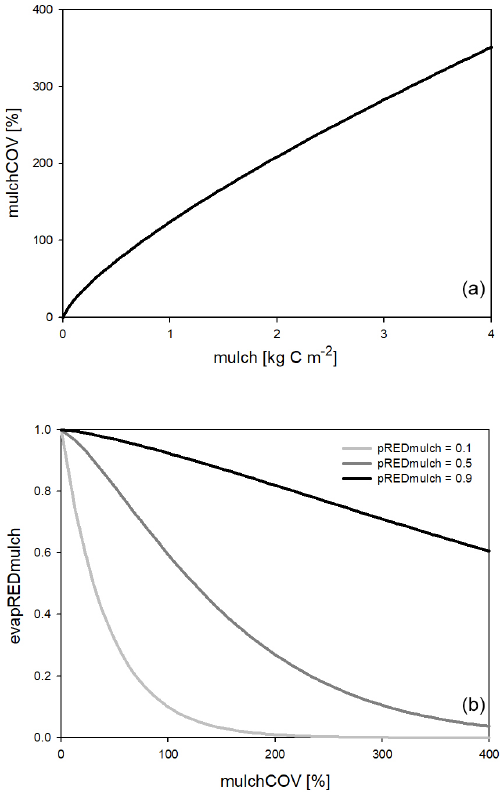
Figure 2. Surface coverage as a function of the amount of surface residue or mulch (a) and the evaporation reduction factor (evap- REDmulch) as a function of mulch coverage (b) using different mulch-specific soil parameters (pREDmulch). See text for